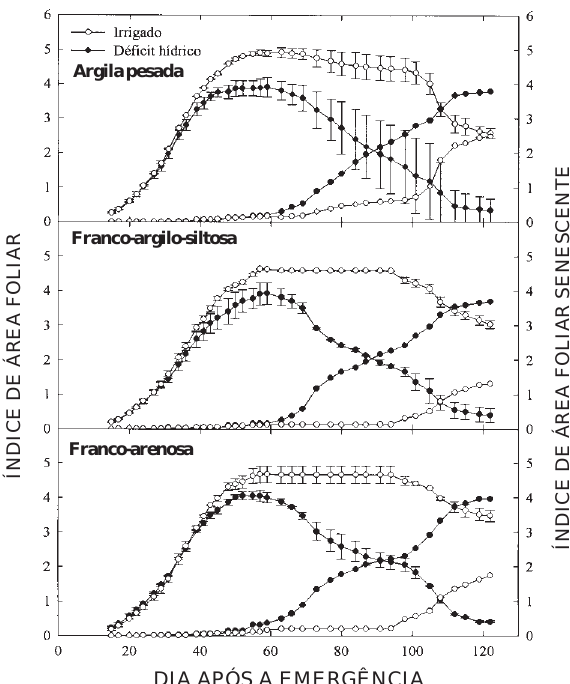
Figura 2. Variação da capacidade de armazenamento de água disponível (CAD) e da fração de água disponível às plantas (FAD) de milho cultivadas em solos de diferentes texturas. As barras verticais representam o